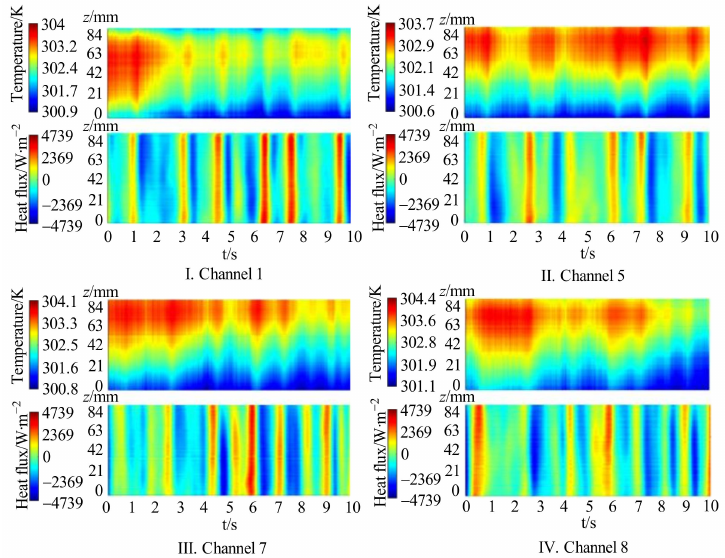
Figure 12. Wall temperature and heat fluxes in different channels under 202 W power input with stable microgravity conditions [196]. Pagliarini et al.,